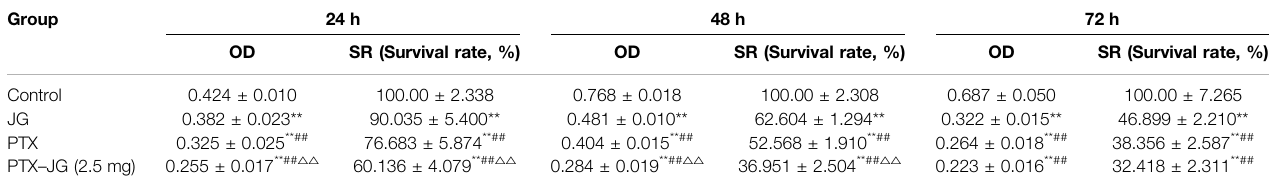
TABLE 4 | Effect of JG on the proliferation of A549/PTX tumor cells.